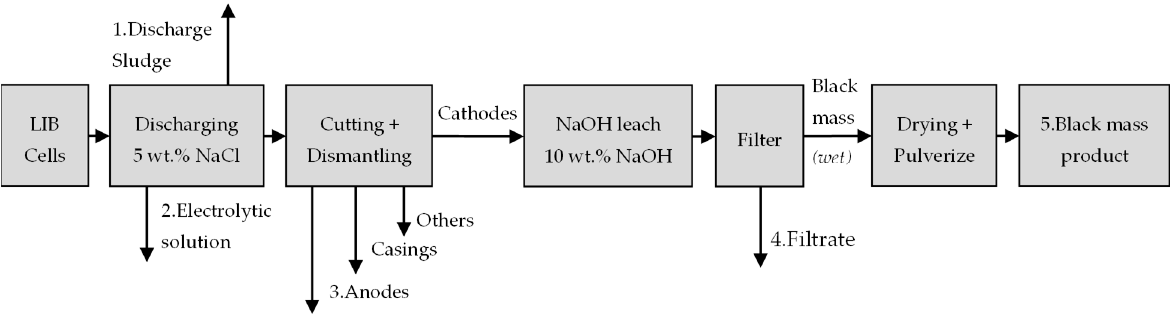
Figure 1. Black mass sample preparation process block flow diagram.